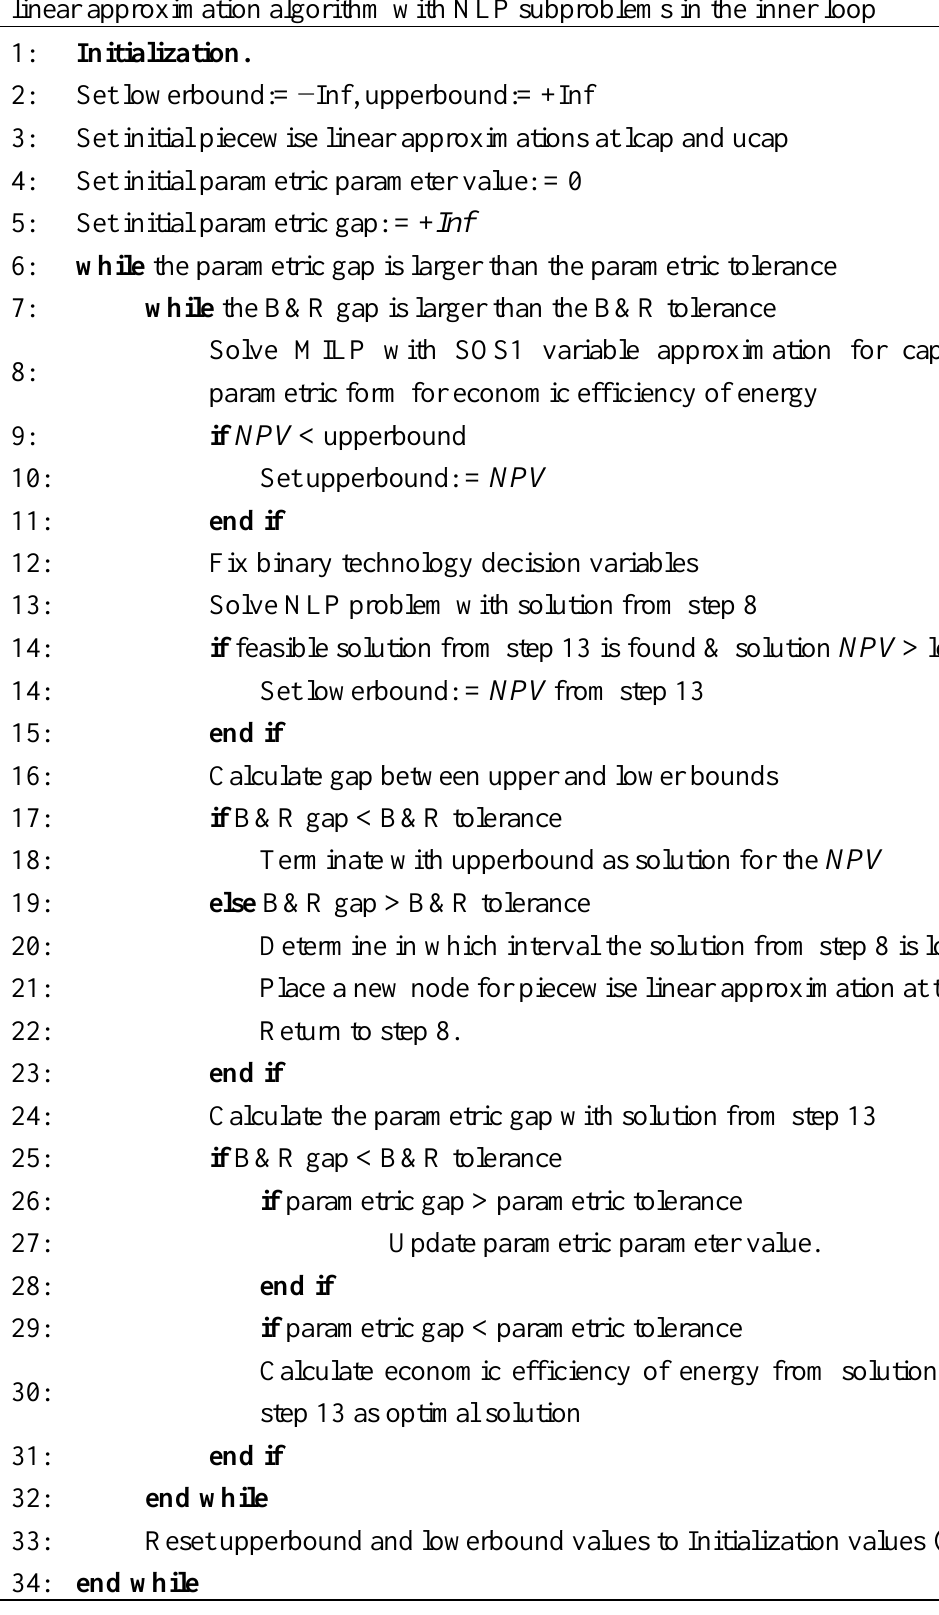
Algorithm. Parametric algorithm outer loop with branch and refine (B&R) + piecewise linear approximation algorithm with NLP subproblems in the inner